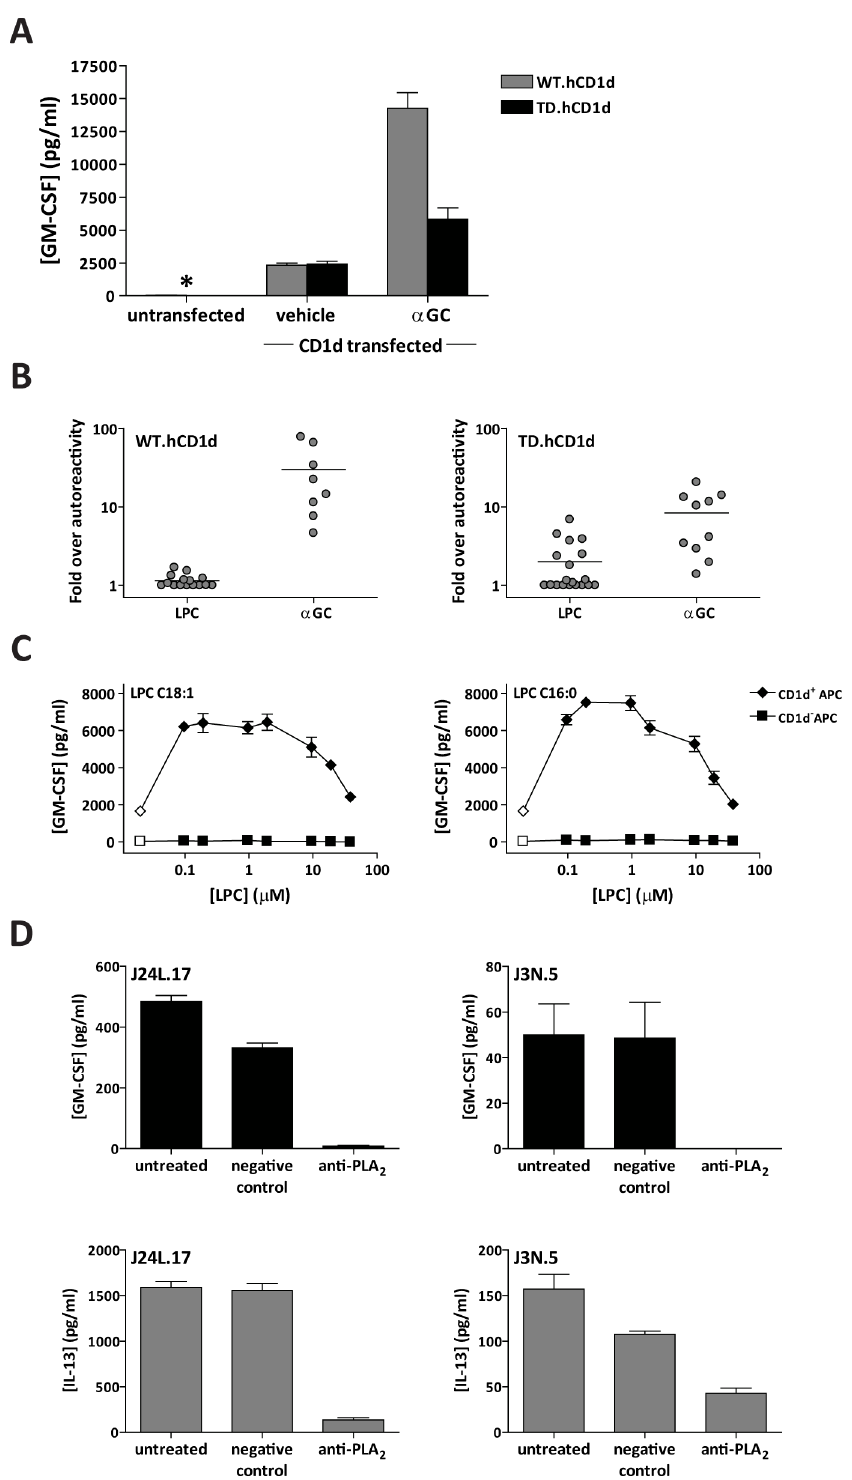
Figure 6. Presentation of LPC by cell surface CD1d. (A) Human lymphoblastoid cell lines transfected with either wild-type (WT) or cytoplasmic tail-deleted (TD) human CD1d molecules, or the untransfected parental cells (i.e., CD1d-negative) were tested for the ability to stimulate cytokine secretion by human NKT cell clones. The cells were pulsed with 7.5 nM a -GalCer ( a GC) or mock treated, then washed and incubated with NKT cell clones. Culture supernatants were collected after 24 h and assayed for GM-CSF (a cytokine produced by the NKT cells) using a standardized ELISA. The plot shows one representative experiment out of three, using clone Jc2.7. Similar results were observed with three other NKT cell clones. The asterisk indicates signal that was below the limit of detection. (B) Transfectants expressing wild-type or tail-deleted CD1d were pulsed with 1–10 m M LPC or 7.5 nM a -GalCer, and used to stimulate human NKT cell clones. Each dot represents an independent analysis, with the data expressed as the amount of cytokine secreted in response to antigen-pulsed APCs normalized by the response to mock-treated APCs. The horizontal line indicates the